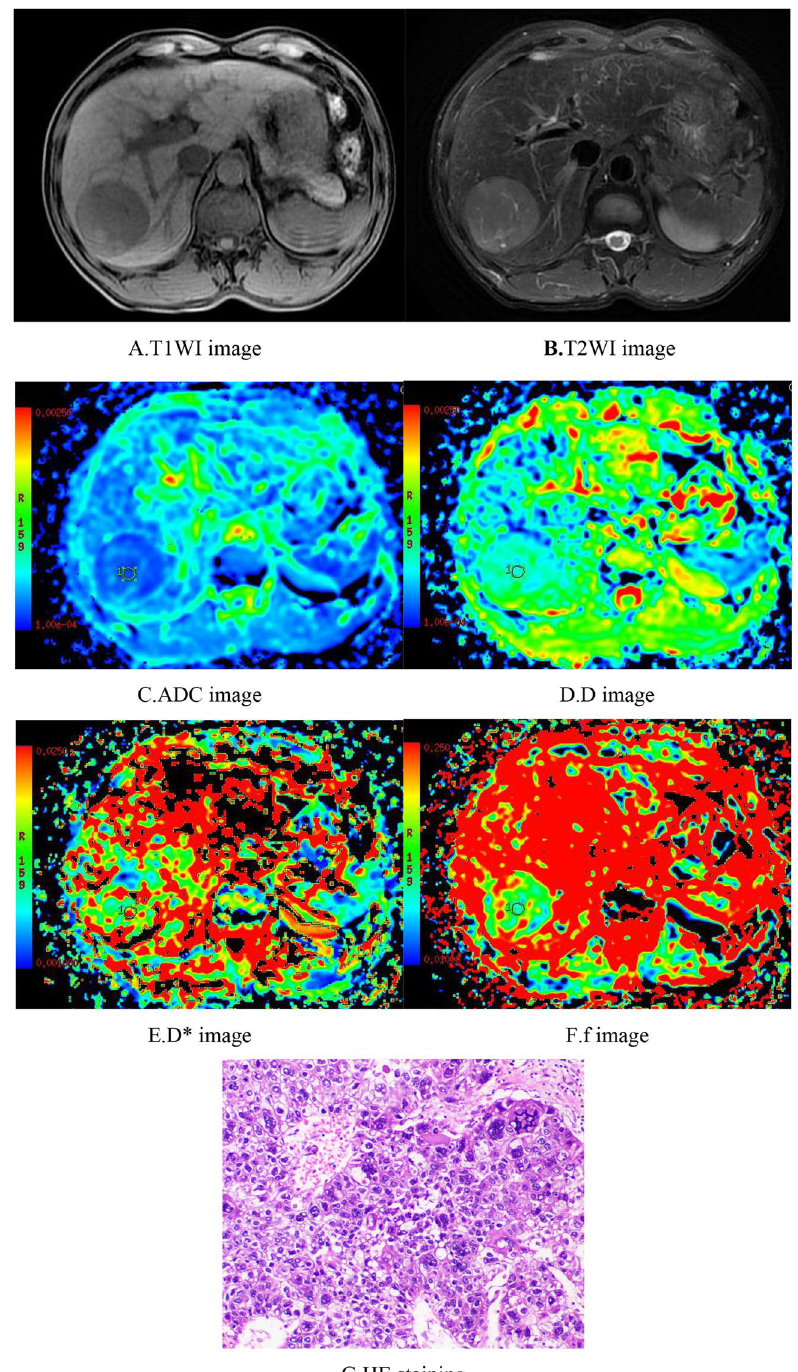
Figure 1. Female, 50 years old, HCC in the right lobe, well differentiated. ( A ) T1WI image. Low-signal area is visible in the right hepatic lobe with a clear boundary. ( B ) T2WI images. The lesion showed a heterogeneous, slightly high signal and a clear boundary. ( C – F ) ADC, D, D*, and f images; the measured values were 1.56 × 10 −3 mm 2 /s, 1.04 × 10 −3 mm 2 /s, 15.50 × 10 −3 mm 2 /s, and 0.29, respectively. ( G ) HE staining (*100) showed well differentiated HCC